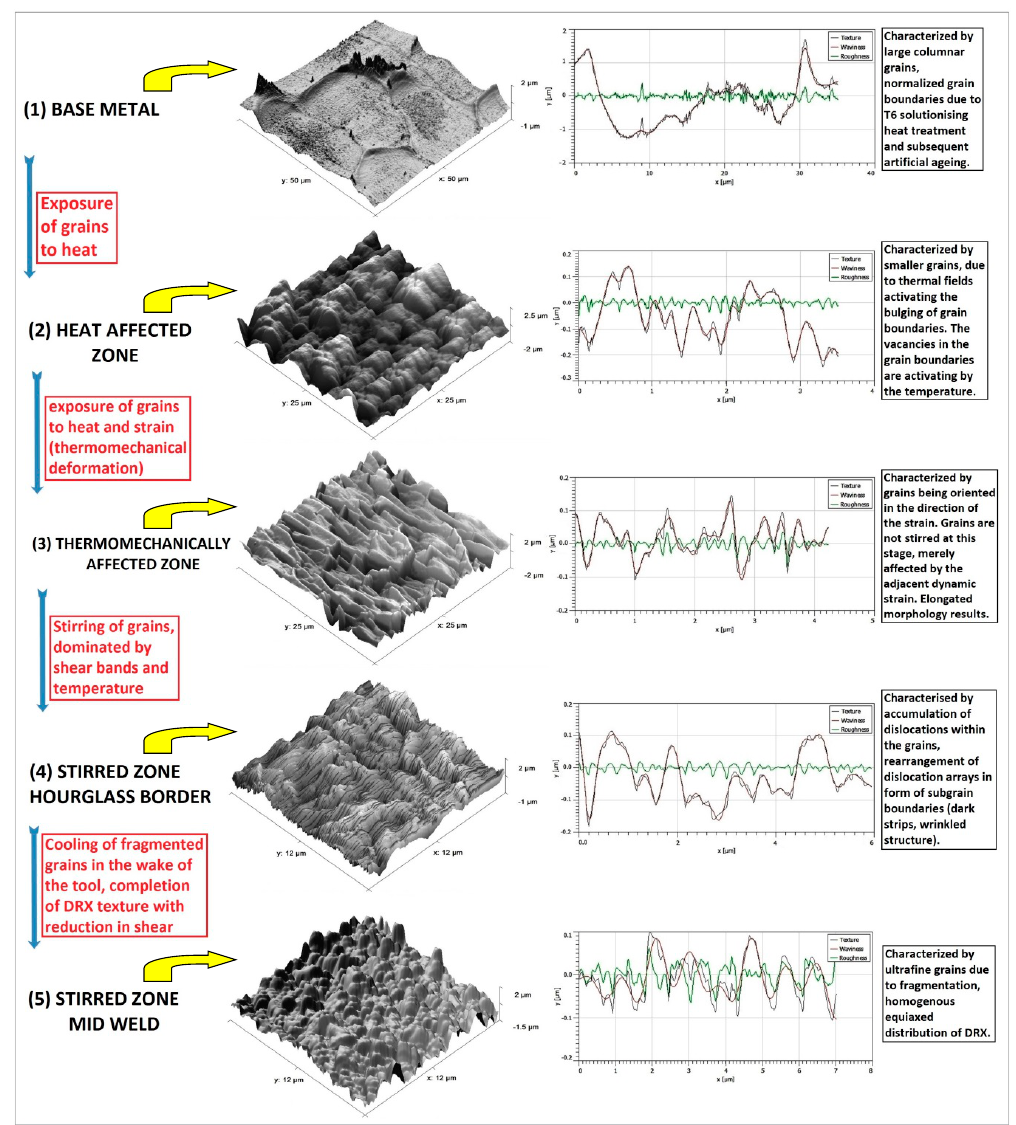
Figure 3. 3D topographic AFM images of different regions of the BFSW weld texture measured by the relevant height profiles of the surface roughness and the in detail explanation of the morphological evolution of the microstructure.